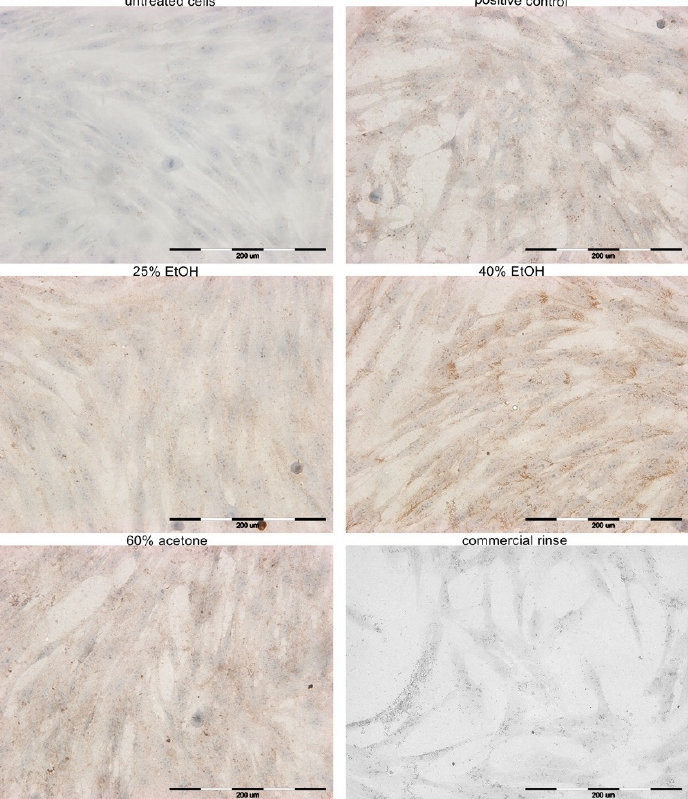
Figure 5. Microphotographs of fibroblasts with immunocytochemically stained collagen type III after 24 h incubation with different extracts of Reynoutria japonica (at 50 µg/mL) and commercial dental rinse (1.56% solution). Note that 25% EtOH, 40% EtOH, and 60% acetone means 25% ethanol extract, 40% ethanol extract, or 60% acetone extract from Reynoutria japonica rhizomes, respectively. Positive control: betulinic acid (2 µM). Magnification on panel: ×200.